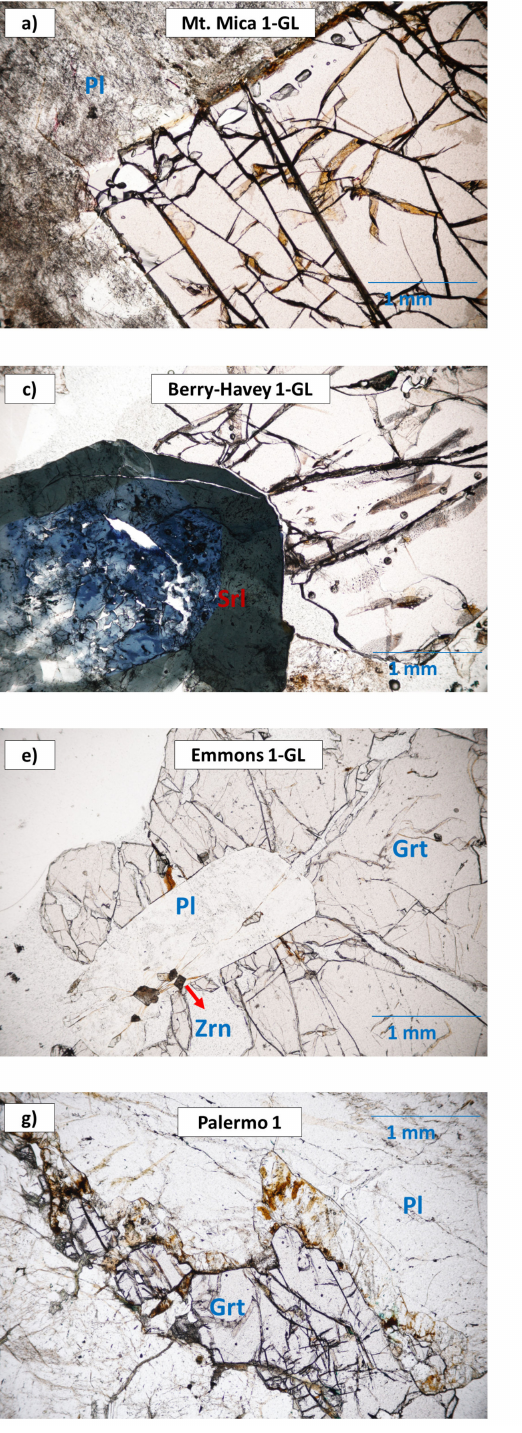
Figure 4. Photomicrographs of garnet from the evolved and intermediate pegmatites. Left: plane-polarized light; right: crossed-polarized light. Abbreviations according to [37]: plagioclase (Pl), muscovite (Ms), garnet (Grt), schorl (Srl), zircon (Zrn), monazite (Mnz), quartz (Qz). ( a , b ) Garnet from the Mt. Mica pegmatite showing a muscovite rim; ( c , d ) Tourmaline crystal from the Berry-Havey pegmatite with the core altered and replaced by very fine-grained phyllosilicates. The garnet shows chromatic zoning. It grows around a tourmaline prism; ( e , f ) Garnet crystal from the host migmatite of the Emmons pegmatite, growing around a plagioclase crystal. The plagioclase shows monazite and zircon inclusions; ( g , h ) Subhedral garnet from the intermediate zone of Palermo No. 1